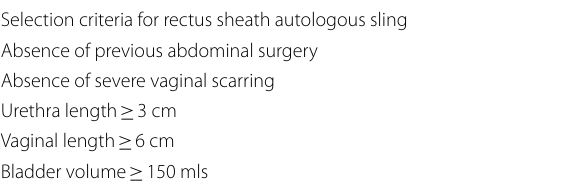
Selection criteria for rectus sheath autologous sling Absence of previous abdominal